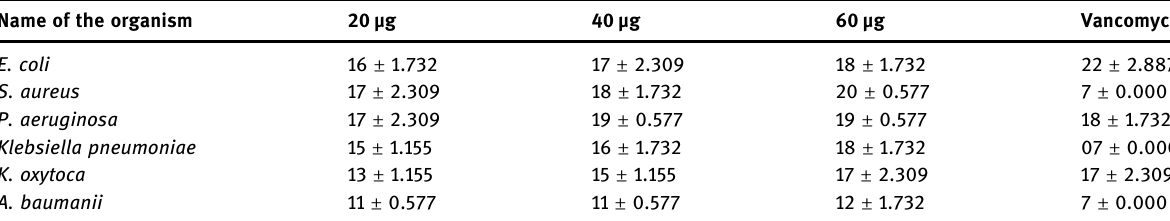
Table 1: Antimicrobial activity of synthesized AS - ZnONPs and antibiotics against the isolates Name of the organism